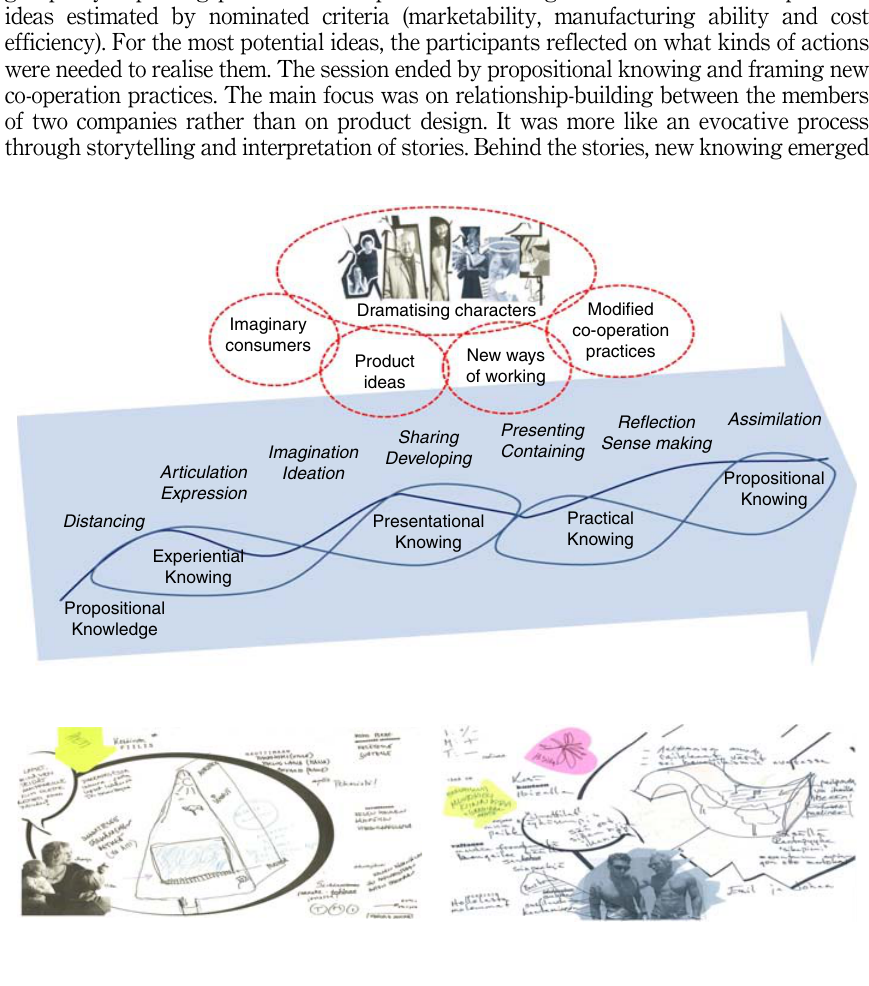
Figure 1. Process of dramatising characters